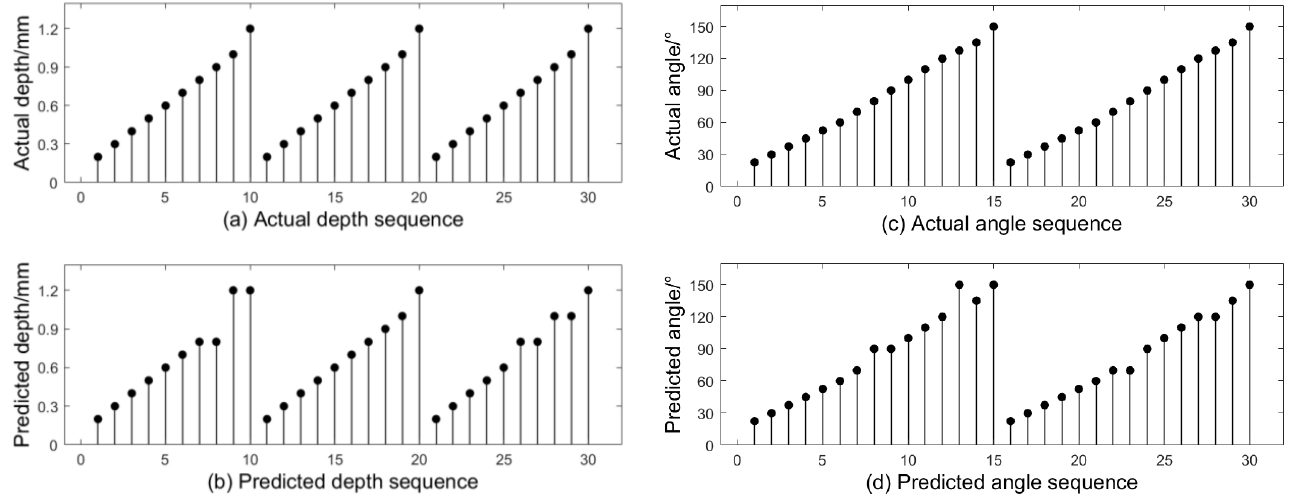
Figure 17. ( a , b ) depth sequence; ( c , d ) angle sequence.